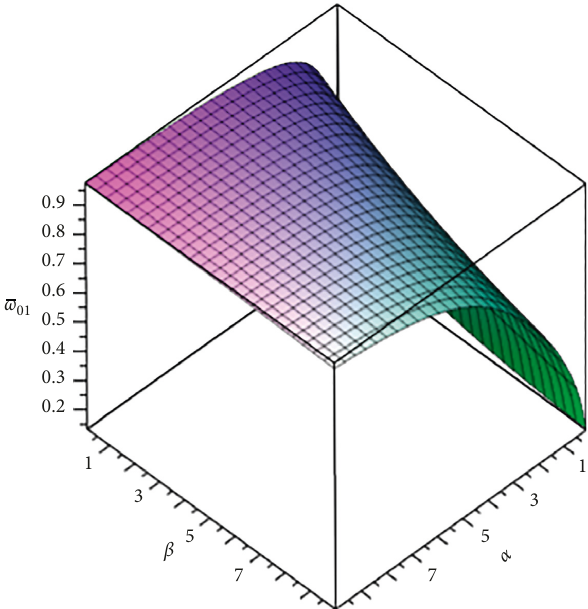
Figure 3: The influence of α and β on the starting frequency.